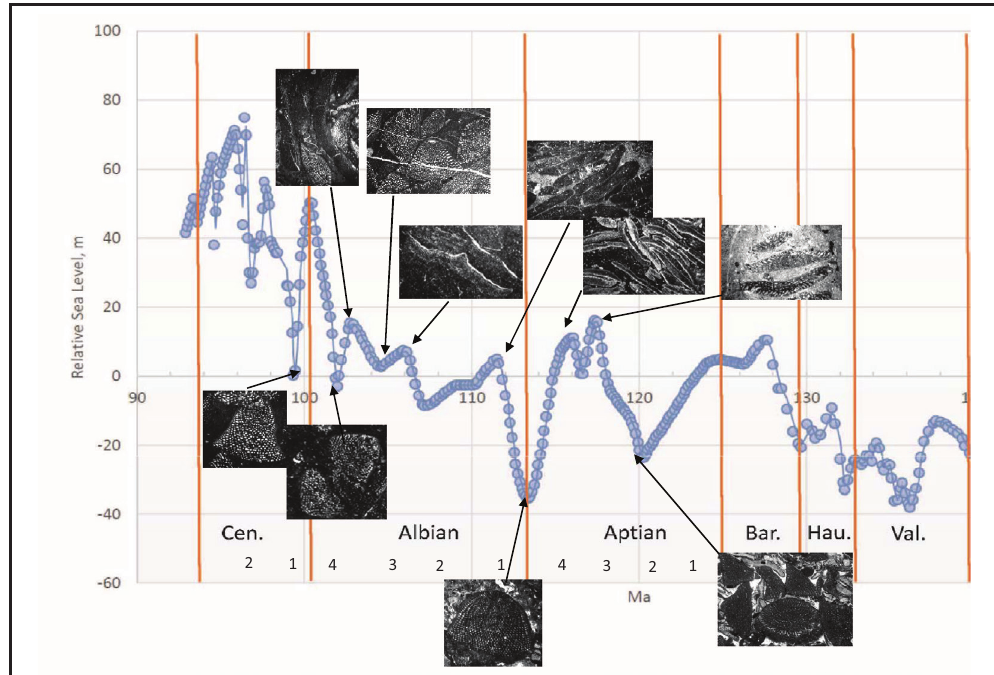
Variation in sea-level during the mid- Cretaceous based on Miller et al. [60] correlated to the boundaries of the PZ after BouDagher-Fadel [2] and showing dominant assemblages at the top of regression and transgression phases.